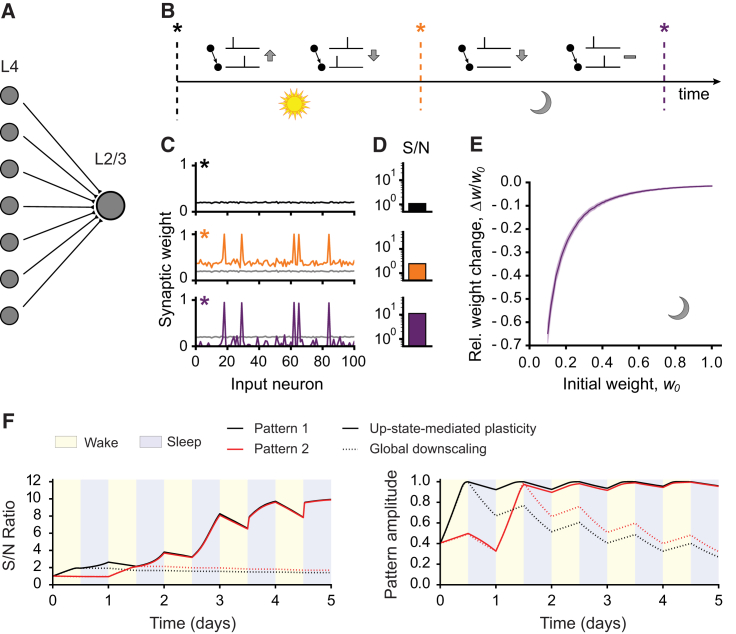
Up State-Mediated Depression Leads to Circuit Refinement in Model Network following Simulated Wake and Sleep(A) Model of a feedforward network with 100 presynaptic L4 neurons projecting onto one single postsynaptic L2/3 neuron.(B) Simulation protocol. Synaptic weights from all connections were initiated with comparable amplitude (black star). For the first half of the simulation (“wake,” sun symbol, 800 s), synaptic weights were updated according to a conventional STDP rule. All presynaptic neurons received an external input to promote spiking and five of them received a 50% stronger input. During the second half (“sleep,” moon symbol, 800 s), synaptic weights were updated with the Up state-mediated synaptic plasticity rule.(C) Synaptic weights for three stages of the simulation. Top, black: start (black star in B). Middle, orange: after “wake” (orange star in B). Bottom, purple: end (purple star in B).(D) Signal to noise ratio (S/N) for the three stages in (C).(E) Relative weight change, Δw/w0, plotted as a function of the initial synaptic weight, w0, after Up state-mediated (sleep) plasticity. 200 simulations were averaged and the shaded area represents the SD.(F) Simulated Up state-mediated plasticity preserves and enhances previously stored patterns. At day 0, five presynaptic neurons received 50% stronger input (pattern 1). At day 1, neurons from pattern 1 did not receive any extra external input, but another set of five neurons did (pattern 2). All presynaptic neurons received comparable external input and fired at the same rate from day 2. Left: evolution of S/N for both patterns (1, black; 2, red). Right: evolution of both pattern amplitudes. During “wake” (yellow), synaptic weights were updated according STDP. During “sleep” (purple), synaptic weights were updated according to either Up state-modulated plasticity (solid lines) or homogeneous synaptic scaling rule (dotted lines). Curves show a mean over 50 trials. See also Figure S4.